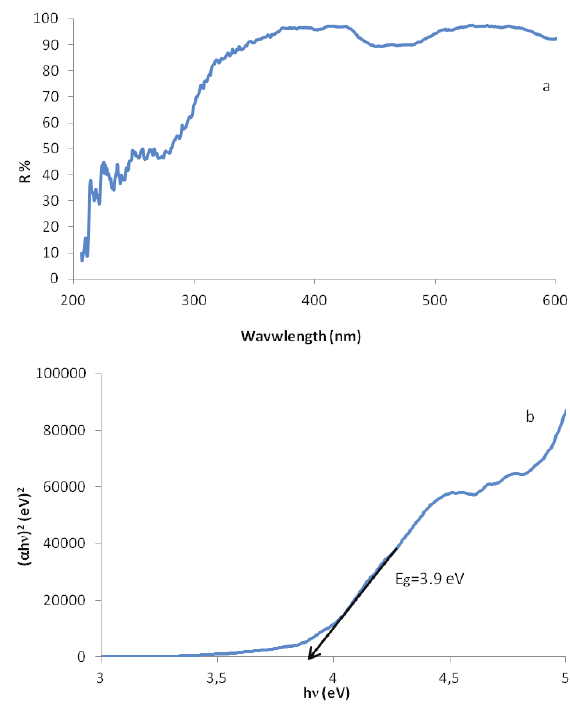
Figure 7: UV-Vis absorption spectra of the a Pr (prepared under optimum conditions) dispersed in distilled water.